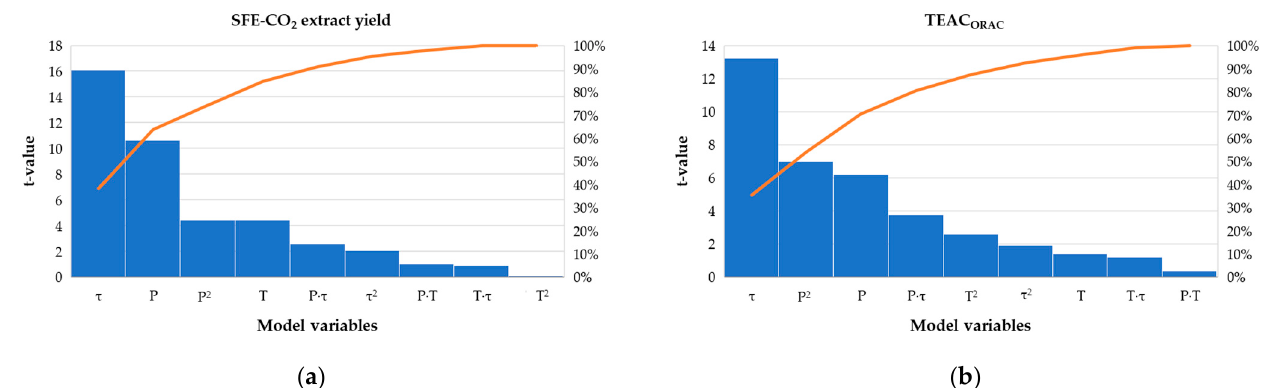
Figure 2. Pareto charts ( p = 0.05) for the main effects of SFE-CO 2 pressure (P), temperature (T) and time ( τ ) and interactions thereof on the Ella hop: ( a ) SFE-CO 2 extract yield (g/100 g HP); ( b ) oxygen radical scavenging capacity (TEAC ORAC , mg TE/g HP).